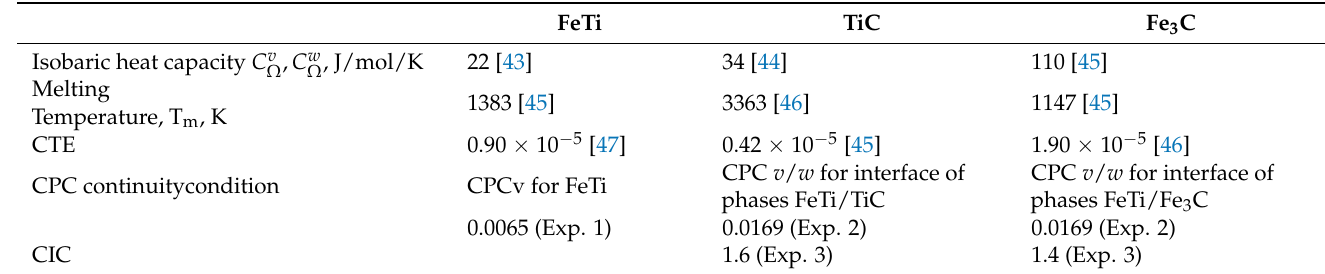
Table 4. CPC and CIC parameters in the area of the TiC/FeTi and Fe 3 C/FeTi phase interfaces. FeTi TiC Fe 3